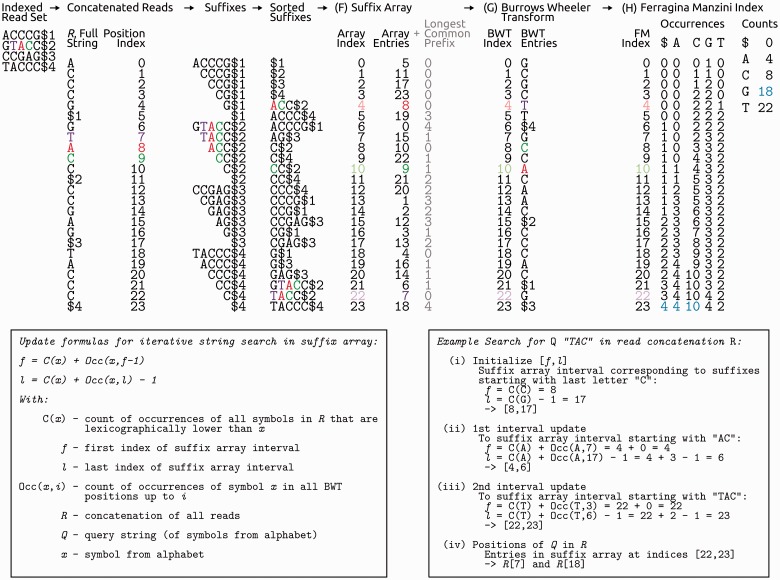
Steps for deriving first a suffix array and then the BWT and the FM index from the running example read set. Also given is an example for a string search using BWT and FM index, with the colours purple, red and green tracing corresponding indices and nucleotides. For suffix array construction, a unique termination symbol ($x) is appended to each read and reads are concatenated to a string R in lexicographical order of their termination symbol ($1<$2 < $3 < $4). All possible suffixes are formed and sorted unambiguously, as termination symbols have an order, as do the other symbols $ < A < C < G < T. A suffix array entry at suffix array index i then corresponds to the position in string R at which the i-th (lexicographically) lowest suffix starts. The LCP of a suffix array entry and the preceding entry is then recorded and suffix array plus LCP already form an efficient data structure for determining string occurrence frequencies. The BWT enables further compression of the data. Here, an entry at BWT index i corresponds to the symbol before the i-th lowest suffix in R. Together with the FM index, it allows for linear time string searches (and thus also determination of the coverage of a string) in the whole read set. The FM index gives the number of occurrences of each of the symbols up to any index of the BWT and for each symbol counts all occurrences of all lexicographically lower symbols (e.g. 4 + 4 + 10 = 18 for symbol ‘G’, all counts in blue). A colour version of this figure is available at BIB online: http://bib.oxfordjournals.org.